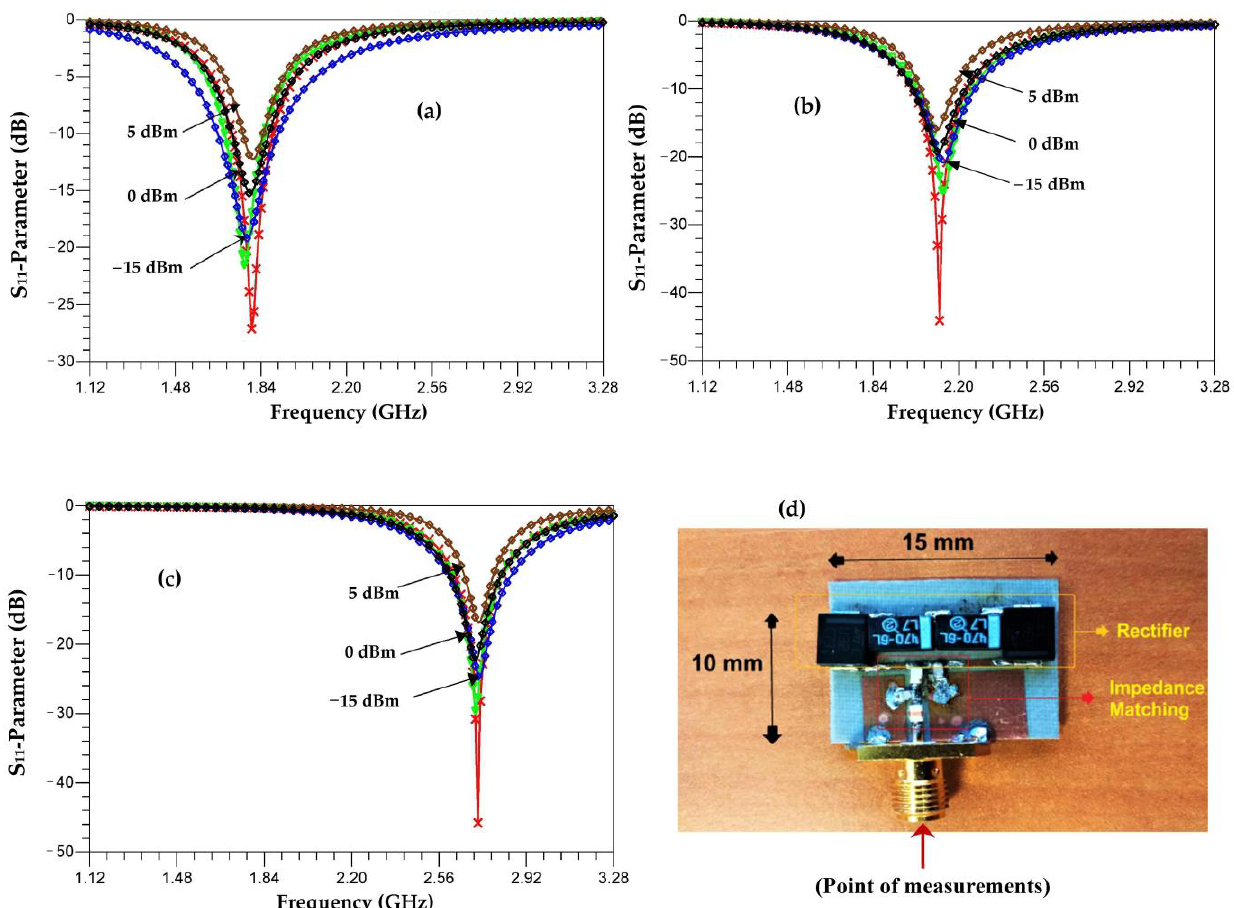
Figure 12. Simulated and measured S 11 parameters of the three rectifiers for each frequency bands (( a ) 1.8 GHz, 2.1 GHz ( b ) and 2.66 GHz ( c )) and realized prototype ( d ). Measurement, Sim- ulation, Co-simulation with parasitic elements .